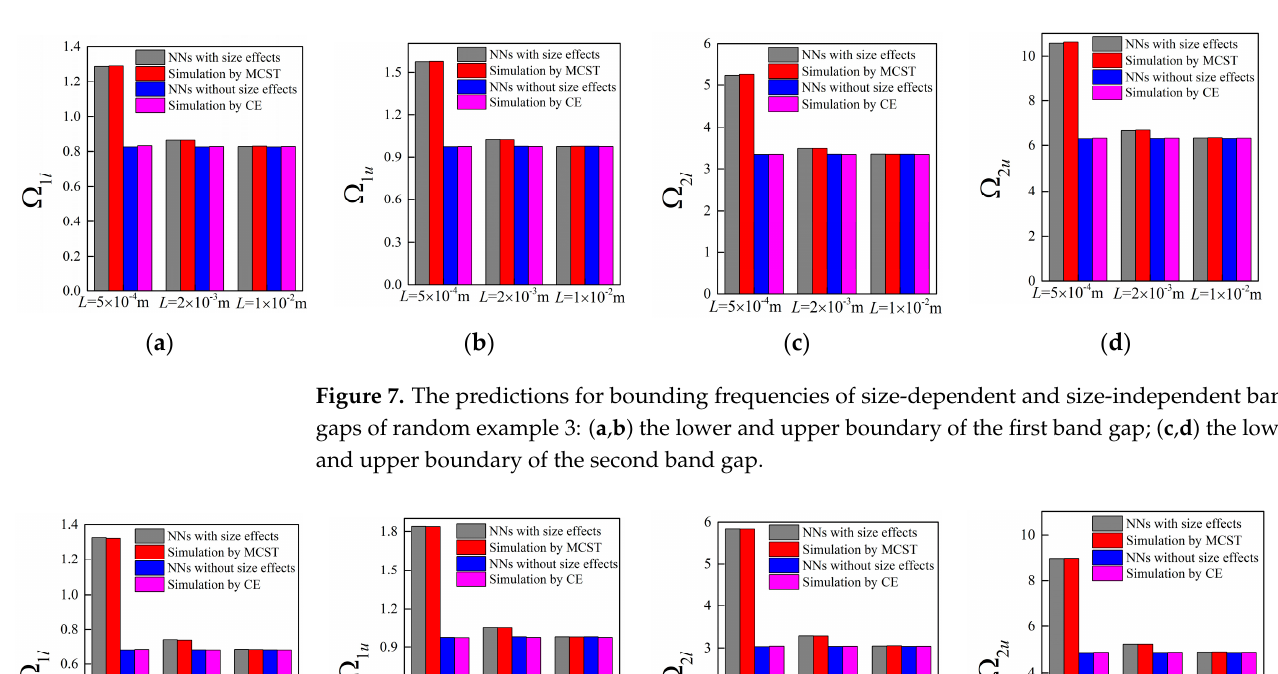
Figure 6. The predictions for bounding frequencies of size-dependent and size-independent band gaps of random example 2: ( a , b ) the lower and upper boundary of the first band gap; ( c , d ) the lower and upper boundary of the second band gap.